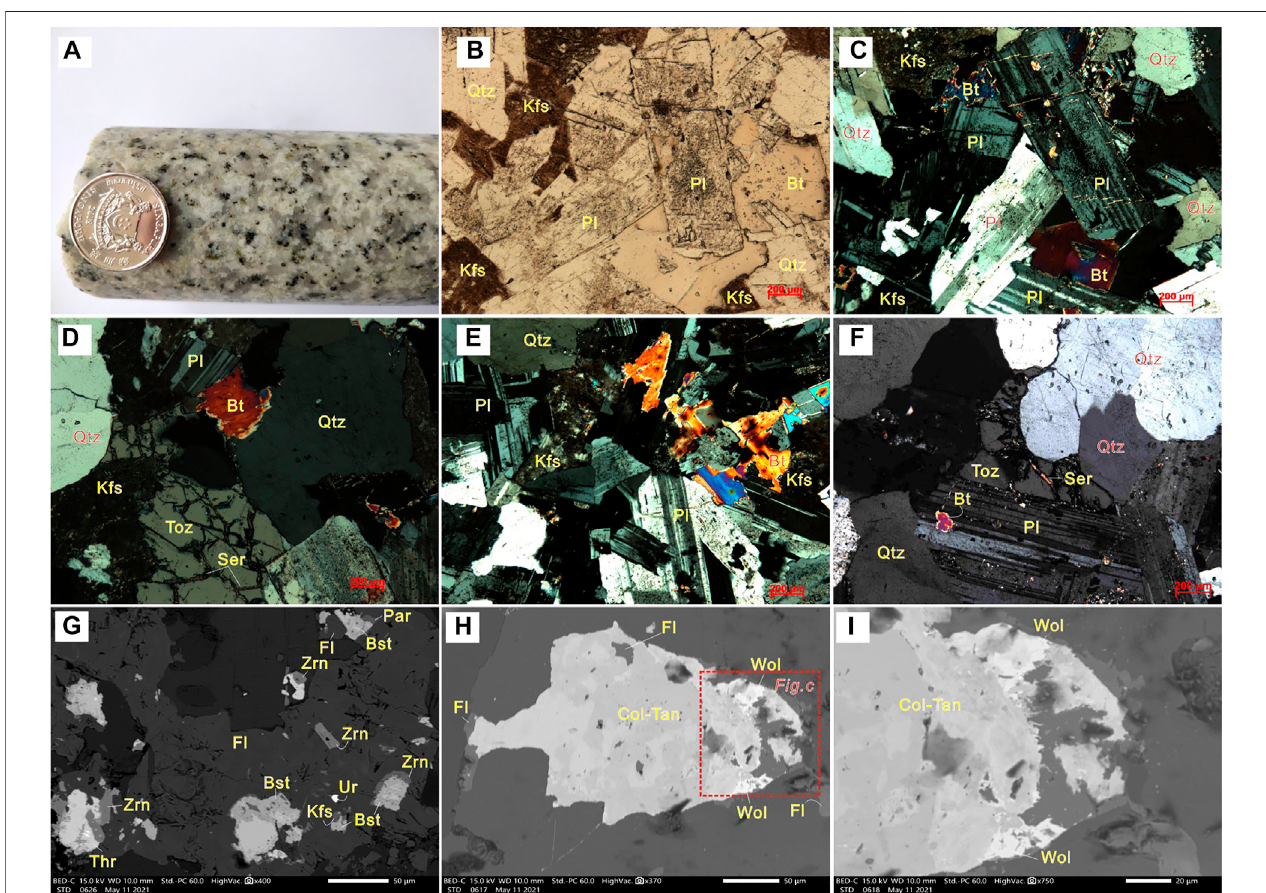
FIGURE3|(A) PhotographoftheJianfenglingbiotite monzograniteinthe fi eld (B – F) Photomicrographs ofbiotite monzogranite; (G) Zircon,bastnaesite,uraninite, and monazite coexist in fl uorite. Bastnaesite replaced monazite, and was then replaced by zircon (H – I) Columbite-tantalite replaced by wolframite. Pl, plagioclase; Kfs, K-feldspar;Qtz, quartz;Bt,biotite;Toz, topaz; Mnz,monazite; Py,pyrite;Zrn,zircon;Bst,bastnasite;Xen,xenotime;Thr,thorite; Fl, fl uorite; Col-tan, columbite-tantalite; Wol,